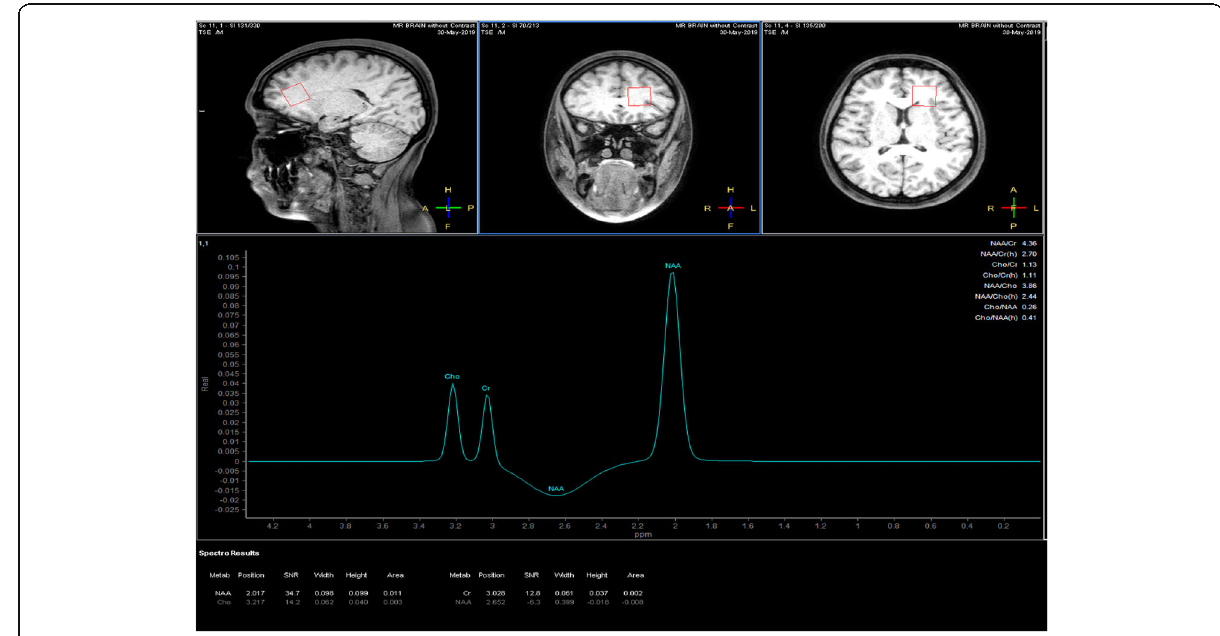
Fig. 2 The location of MRS voxel with a representative spectrum in the left frontal white